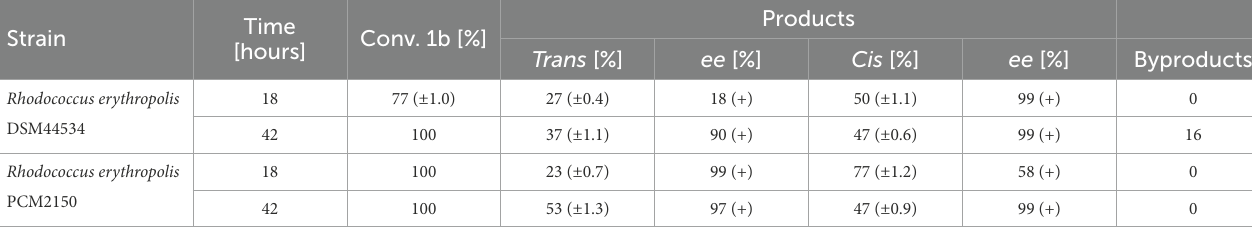
%, determined by CGC.